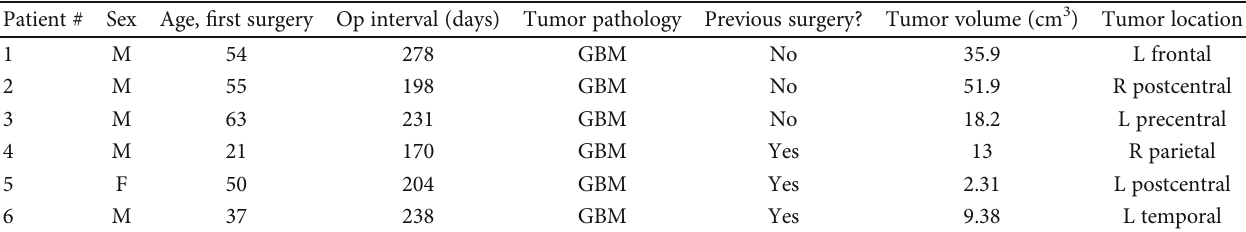
Table 1: Patient demographics. Six patients fi t the inclusion criteria for this study between 2010 and 2016. Listed are their sex, age at fi rst operation (years), operative interval (days between the fi rst and second operations), tumor pathology, tumor volume (cm 2 ), and tumor location (if tumor was not speci fi cally in the pre- or postcentral gyrus, lobe is listed).